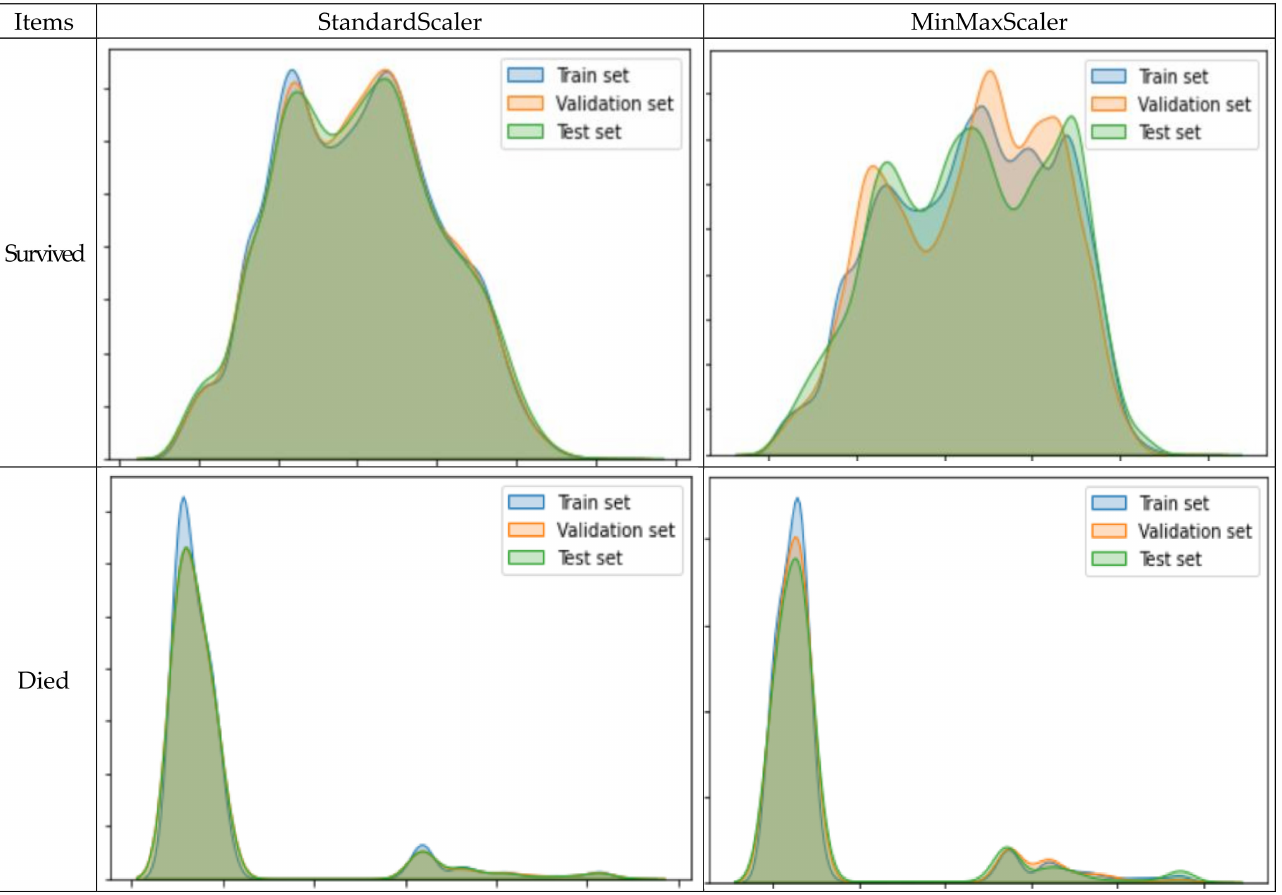
Figure 3. Comparison of standardization